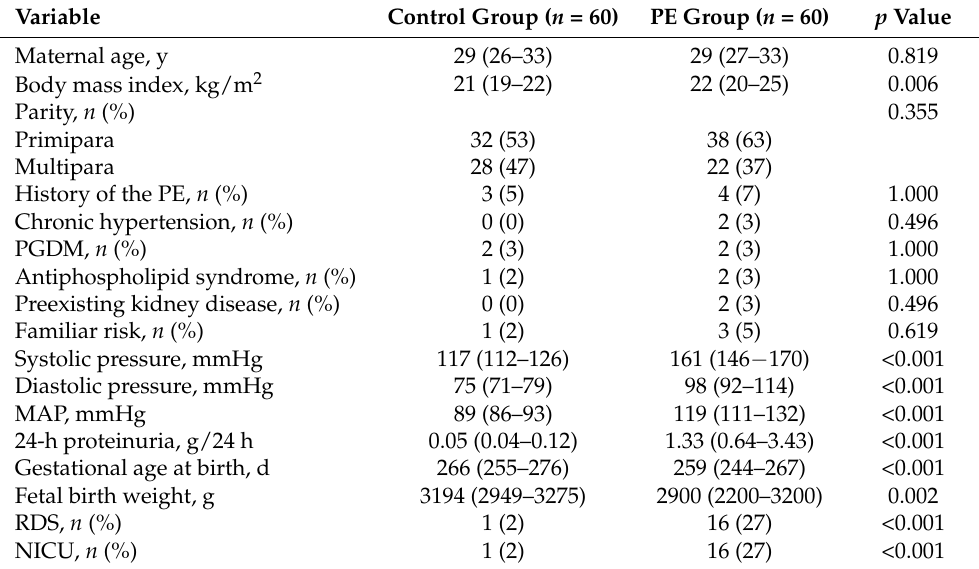
Table 1. Demographic characteristics of the participants in this